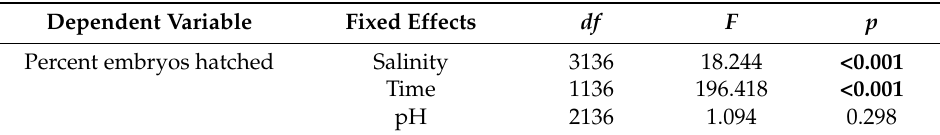
Table 3. ANOVA for the effects of salinity, pH, time, block (male/female cross), and their interactions on the percent of embryos hatched. Data were arcsine-square root transformed prior to analysis. Significant effects ( p < 0.05) are in